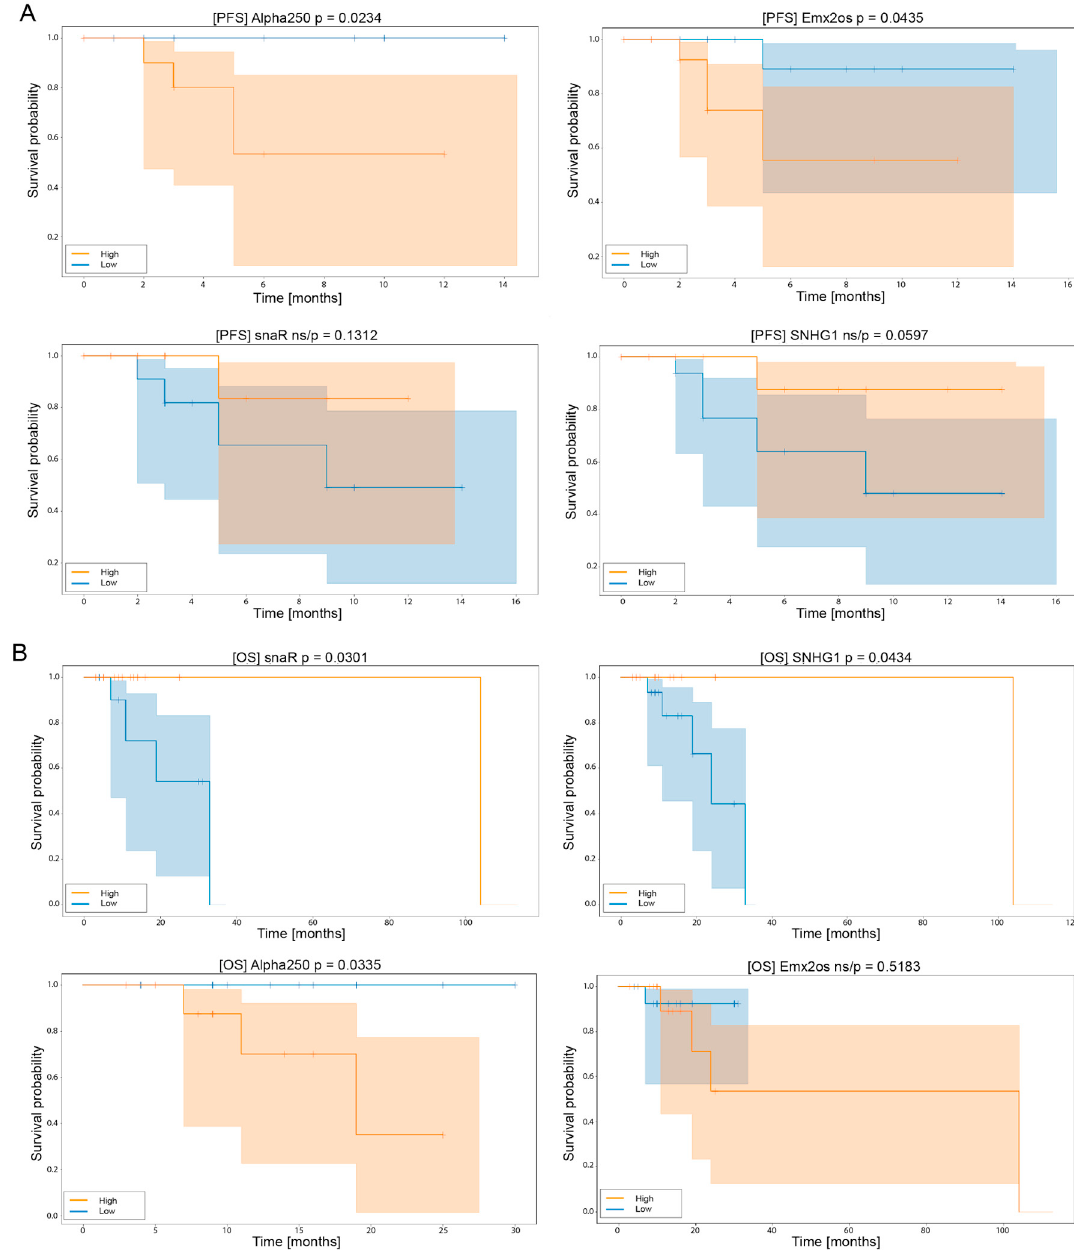
Figure 7. Progression free survival probability ( A ) and overall survival probability ( B ) of HNSCC patients receiving palliative chemotherapy depending on expression levels of Alpha 250, Emx2os, snaR and SNHG1 lncRNAs. Patients were divided into two subgroups according to high (red) / low (blue) expression levels of lncRNA, Kaplan–Meier analysis, and p < 0.05 considered as statistically significant.